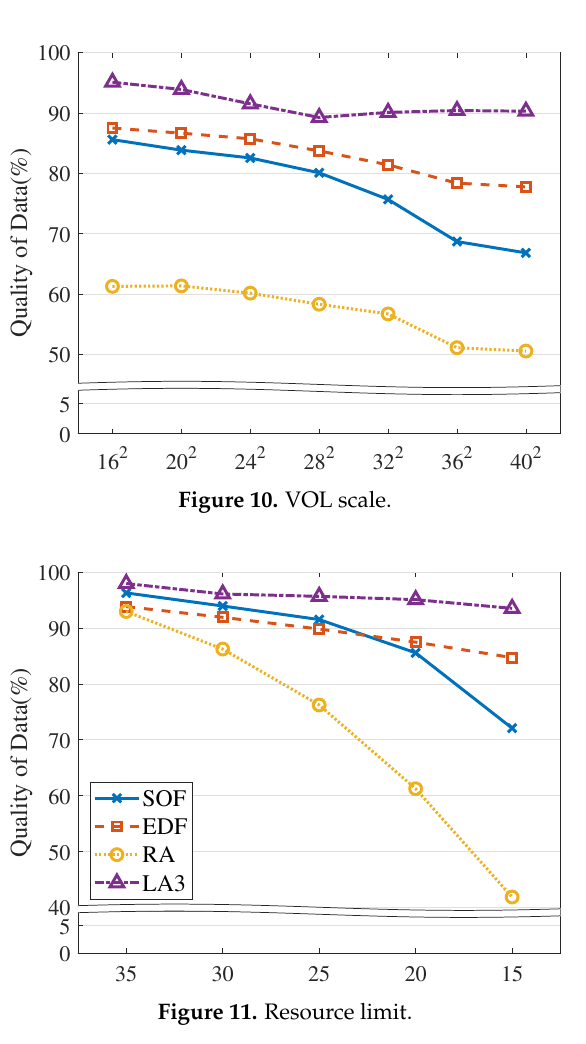
Figure 11. Resource